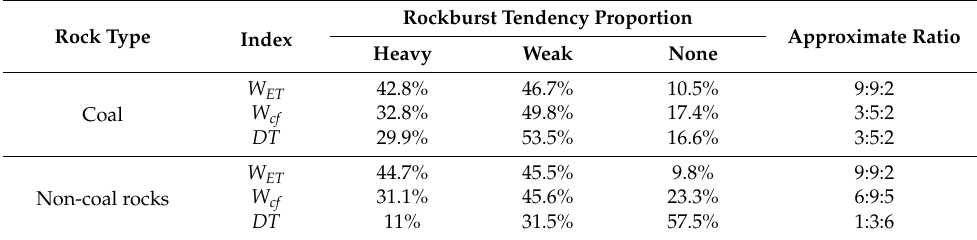
Table 3. Rockburst tendency ratios of coals and non-coal